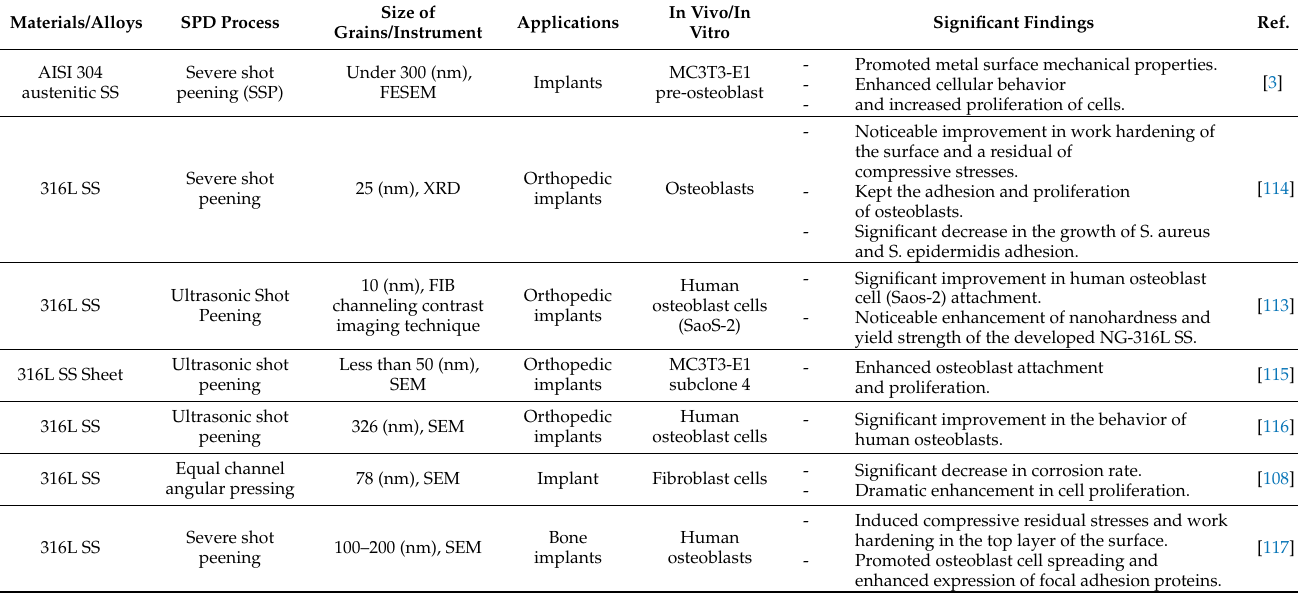
Table 3. Summary of studies on UFG/NG stainless steel as produced by